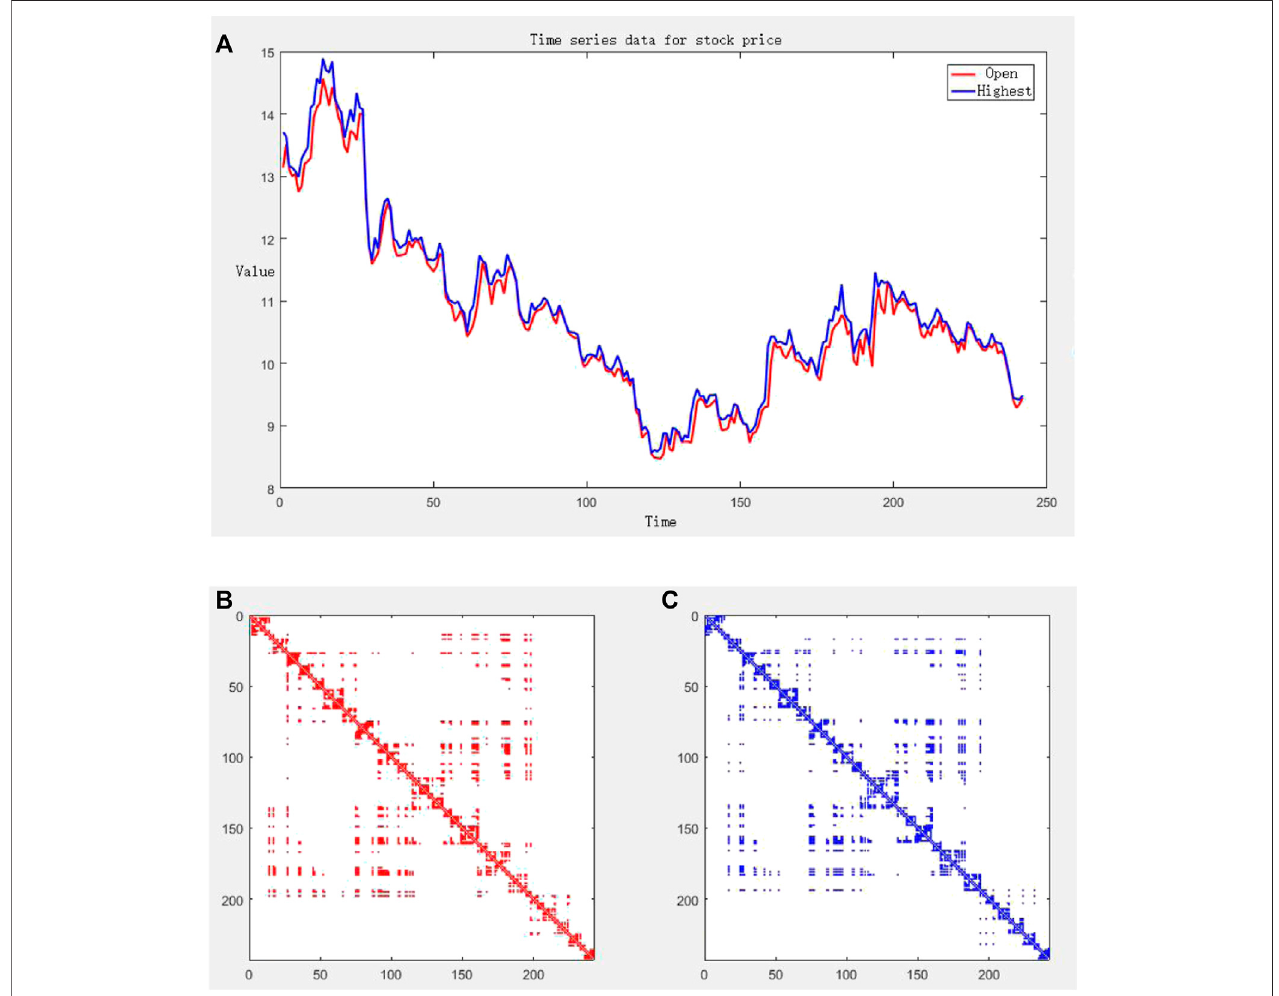
FIGURE 9 | (A) The opening stock price and highest stock price of Ping An Bank Co.; (B) Adjacent matrices of the networks obtained through MVG for opening price; (C) Adjacent matrices of the networks obtained through MVG for highest price.